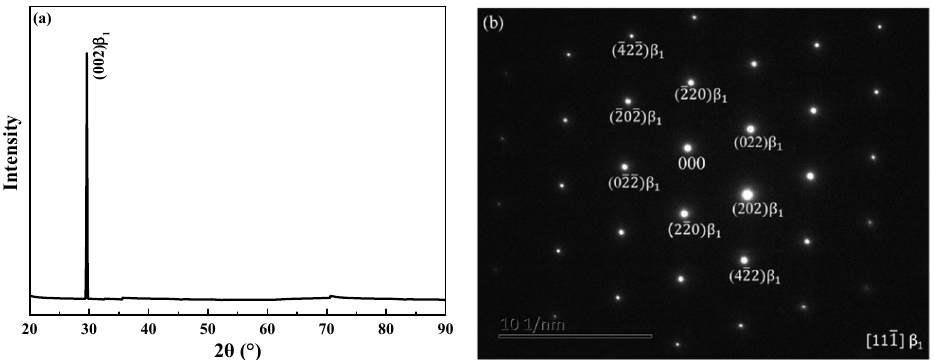
Figure 3. ( a ) XRD profile; ( b ) TEM diffraction pattern of columnar-grained Cu 71.7 Al 18.1 Mn 10.2 alloy sample.